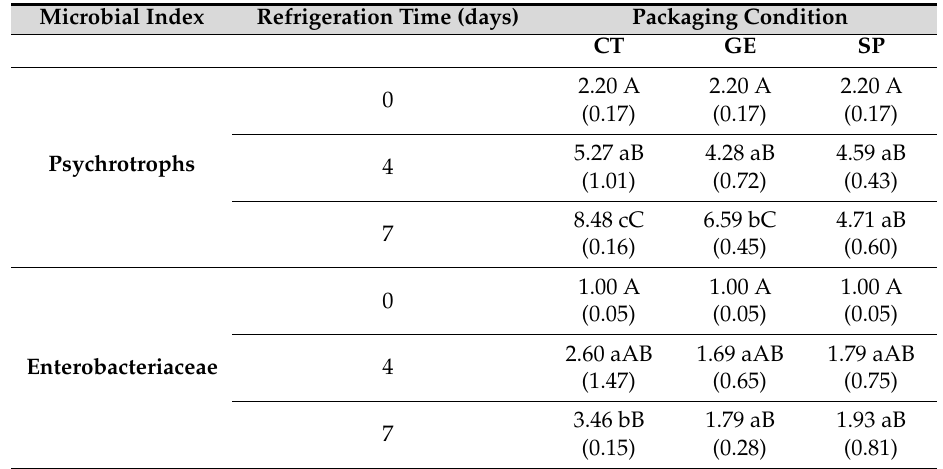
Table 1. Psychrotrophs and Enterobacteriaceae count assessment (log CFU · g − 1 muscle) * in mackerel muscle stored under di ff erent packaging conditions